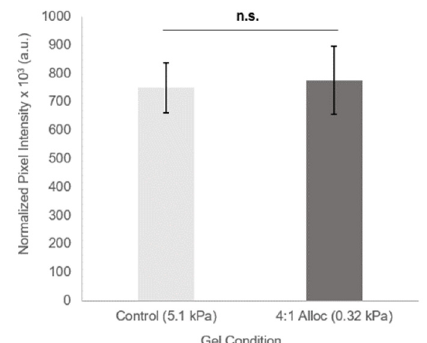
Figure 5. Biomolecule density with and without H-Lys(alloc)-OH competing monomer are comparable. Average fluorescence of gels at 488 nm, normalized to fluorescence of gels with 0 µM PEG-RGDS-Alexafluor 488. Values reported as mean ± S.D. n.s. indicates no significance. p = 0.8176, statistical analysis evaluated by Student’s t -test. n = 3 gels.